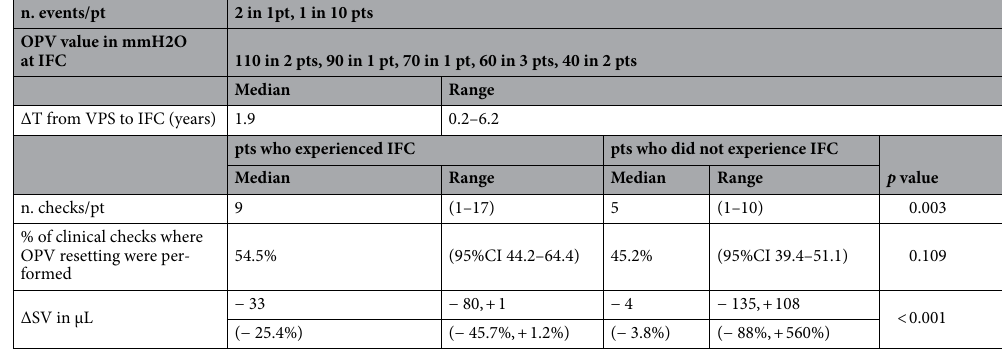
Table 2. Aqueductal cerebrospinal fluid stroke volume changes, opening pressure valve data during follow-up, in 11 cerebrospinal fluid shunted patients with idiopathic normal pressure hydrocephalus who experienced intracranial fluid collection and comparison with no complicated patients. CI confidence interval, ∆T time interval, IFC intracranial fluid collection, n . number, OPV opening pressure valve, pt(s) patient(s), VPSp ventriculo-peritoneal shunt placement. Clinical check indicates the clinical evaluation possibly associated with aqueductal cerebrospinal fluid stroke volume (SV) measurement and/or OPV resetting; in IFC patients ∆SV indicates the difference between SV values from the check where IFC was detected and the previous one, while in patients who did not experience IFC indicates the median of SV changes during follow-up.